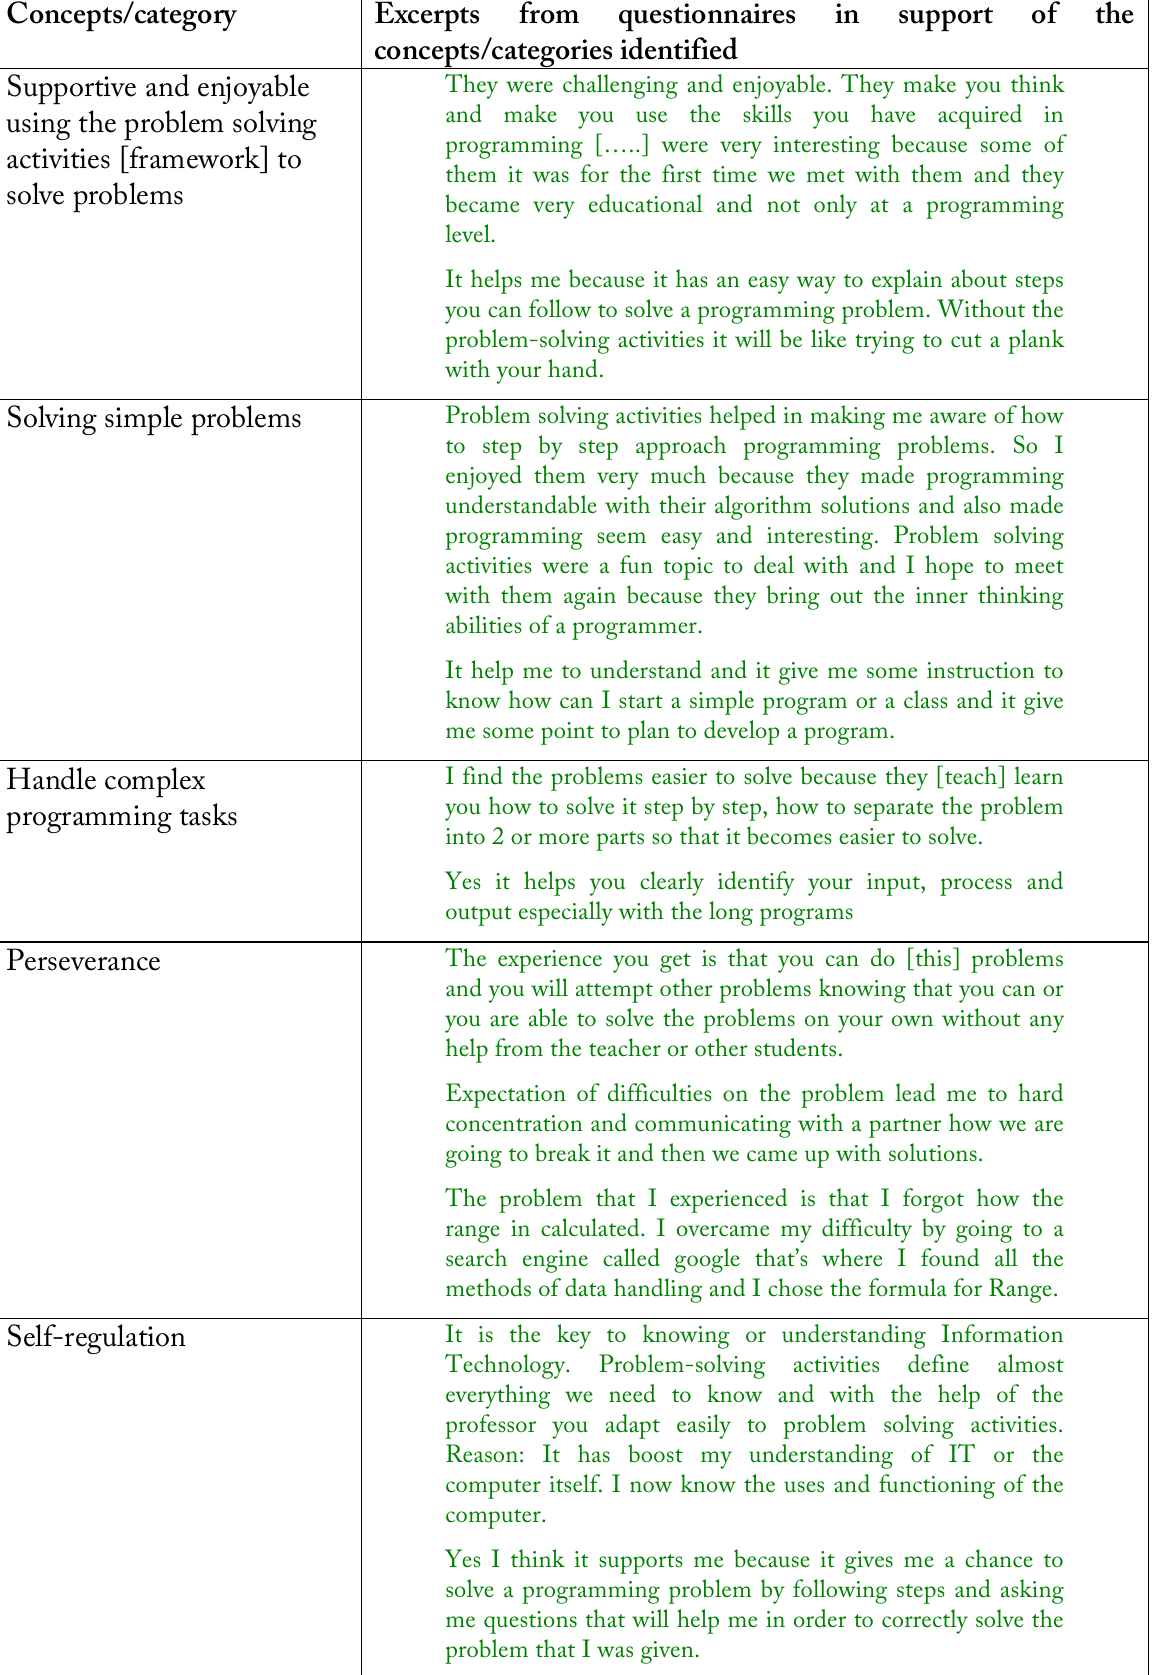
Table 3: The identified concepts with examples of evidence from the data